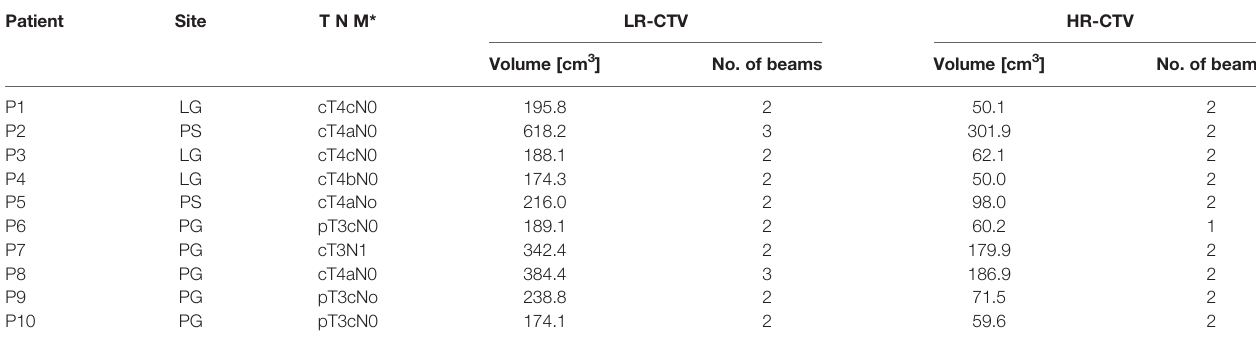
TABLE 1 | Clinical information of the adenoid cystic carcinoma patients.